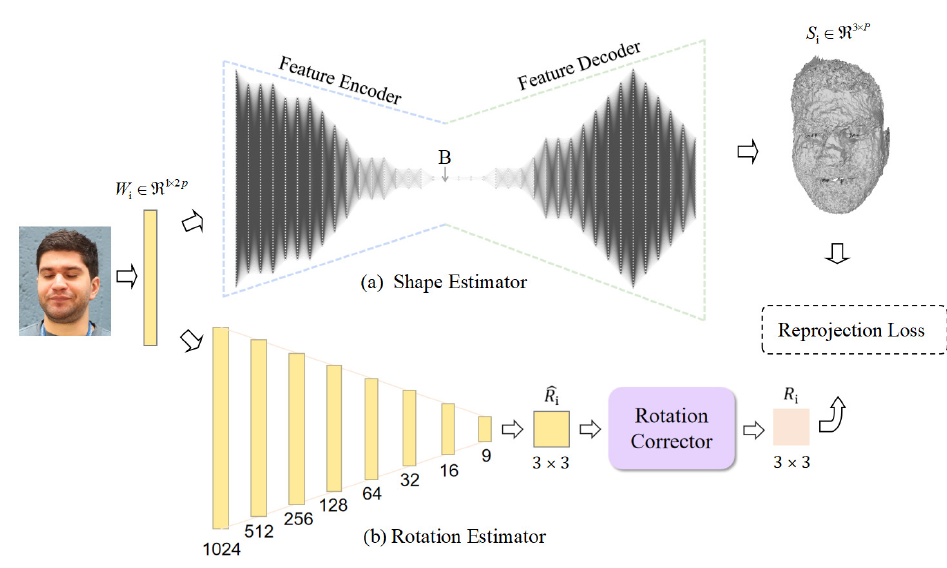
Figure 2. Schematic of the reconstructor: ( a ) Shape estimator for predicting the 3D structure of the reconstructed object. ( b ) Rotation estimator for estimating camera poses in each